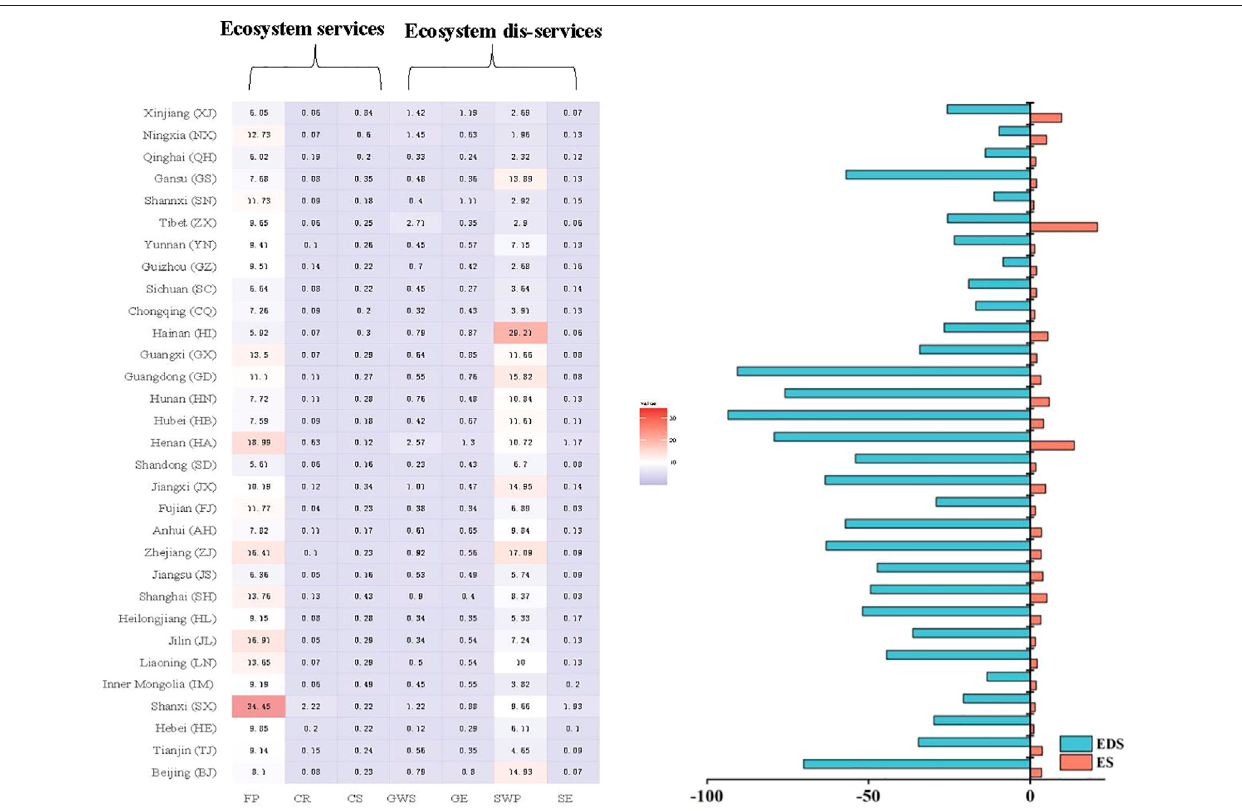
FIGURE 4 | Ecosystem services and dis-services in each province in China (1E+12sej/kg).